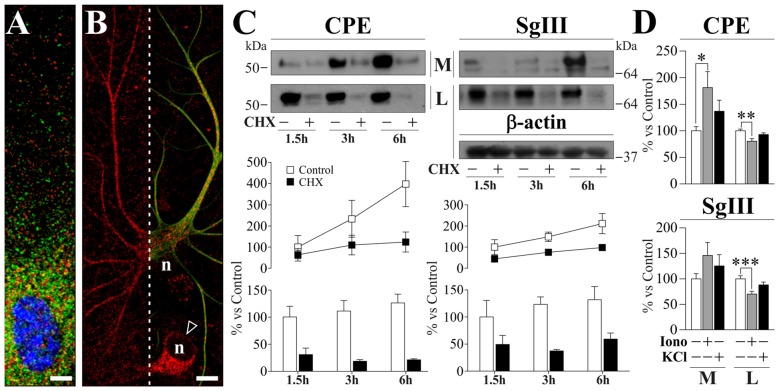
Localization and release of CPE and SgIII in cultured cortical astrocytes. (A,B). Confocal immunofluorecence images in astrocytes grown in glial (A) and neuronal (B) enriched cultures. High magnification in (A) shows a poor co-localization (yellow signal) of CPE (green) and SgIII (red) around the nucleus (blue). The astrocyte identity of a process-bearing cell positive for SgIII (red) is revealed by GFAP (green) co-staining (right in B). In (B), arrow-head points to a neuronal soma displaying SgIII (red) and n indicates nucleus location. Scale bars in μm: (A) 5; (B) 15. (C) Immunoblots illustrate cellular content (lysates, L) and basal secretion into the medium (M) of CPE and SgIII in astrocyte cultures treated or not with 7.5 μM CHX during 1.5 h, 3 h and 6 h. β-actin was used as loading control. The graphs below summarize percent variation of the extracellular (lines) and intracellular (bars) levels of CPE and SgIII after CHX administration compared to controls. Data are presented as the mean ± standard error of the mean (SEM) of a representative experiment performed in quadruplicates. (D) Histograms summarizing the effect of 1 μM ionomycin (Iono) and 55 mM KCl incubations over 15 min on release (M) and cell content (L) of CPE and SgIII. Values represent percent variation compared with controls and are presented as the mean ± SEM. All the data (M and L) was normalized by intracellular levels of β-actin. *p < 0.05; **p < 0.01; ***p < 0.001, Mann-Whitney test.